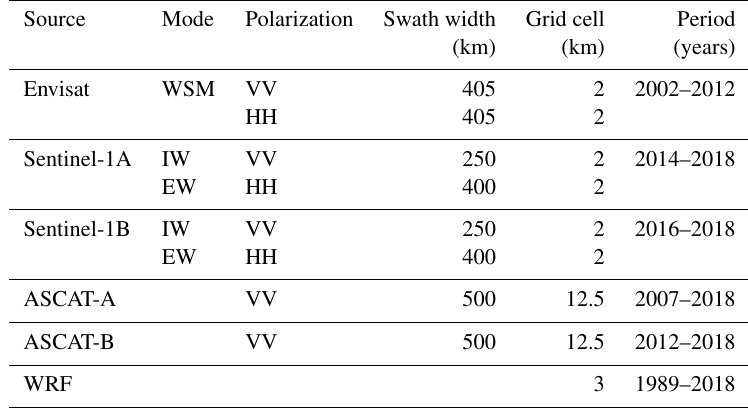
Table 1. List of source data for the European seas between 1989 and 2018 for ASCAT, SAR and WRF. Source Mode Polarization Swath width Grid cell Period Envisat WSM